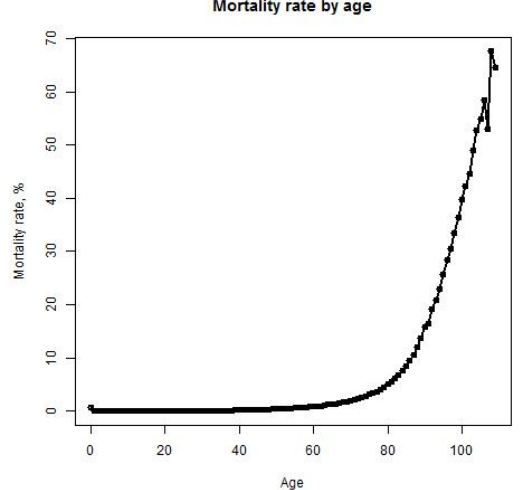
Figure 3. Mortality rate in the United States in 2010. The X-axis represents age and the Y-axis represents the mortality rate in percent. The mortality rate is calculated as the ratio of the number of deaths among people of a certain age to the total number of people of a certain